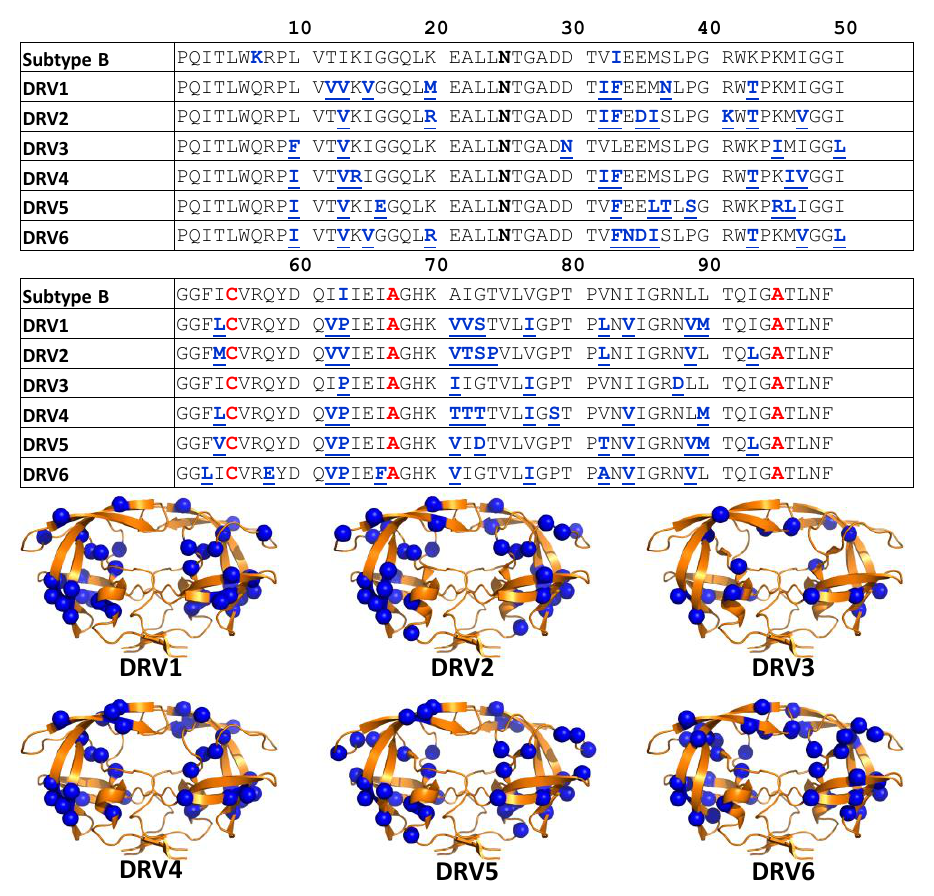
Figure 2. ( Top ) Graphical table showing darunavir (DRV) 1-6 HIV-1 PR sequences with boldfaced underlined residues in blue indicating substitutions relative to PI-naïve subtype B. Blue bold-face residues in sequence of PI-naïve subtype B indicate stabilizing mutations (Q7K, L33I, and L63I). Black boldfaced annotation for D25N shows these constructs contained an inactivation of the catalytic site to aid in stabilization. Red boldfaced labels indicate locations modified for DEER investigations as described in the Materials and Methods. ( Bottom ). Ribbon diagrams of HIV-1PR (PDBID: 2PK5) with spheres showing the locations of the amino acid substitutions in DRV1-6 relative to PI-naïve subtype B.